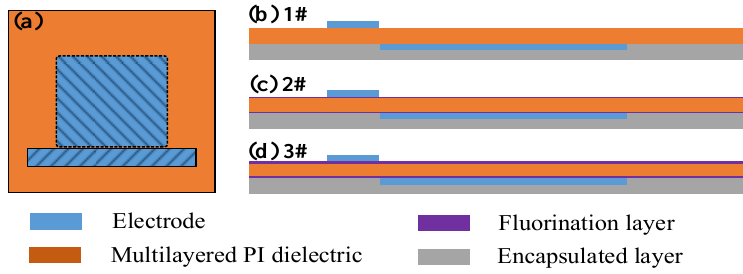
Figure 1. Top view of Surface Dielectric Barrier Discharge (SDBD) plasma device ( a ) and cross section of SDBD plasma devices with un ‐ fluorinated PI ( b ), 30 min fluorinated PI ( c ) and 60 min fluorinated PI ( d ); Not scale.